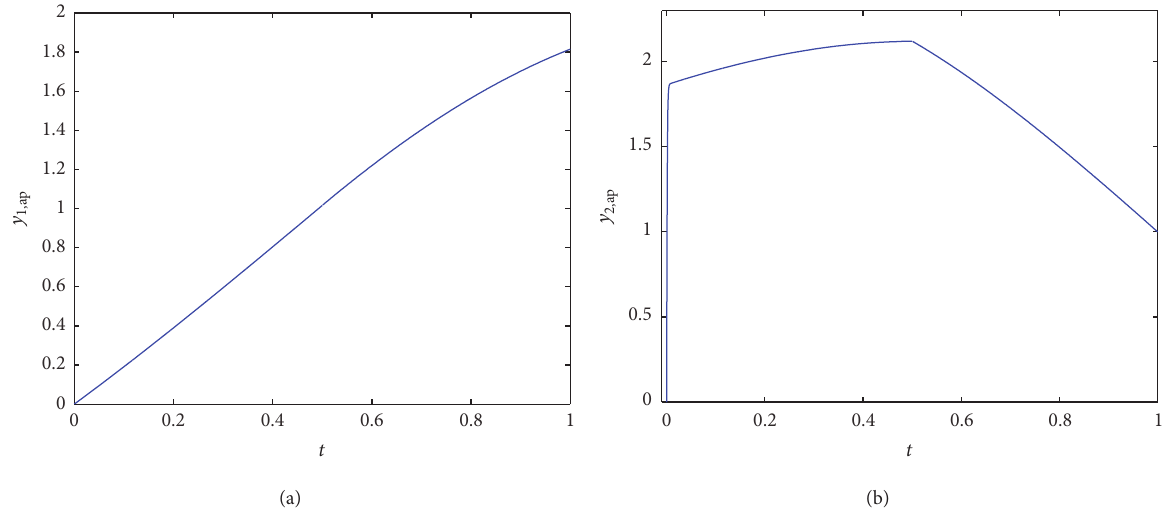
Figure 2: Graphs of the approximate solution 𝑦 1, ap and its first derivative 𝑦 2, ap for Example 2 at 𝜀 = 2 −9 and 𝑁 = 5 .